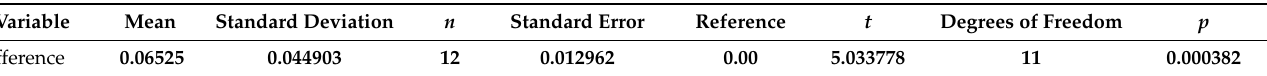
Table 10. t -test of the average difference between the SfM and manual methods against 0. Bold indicates statistical significance.